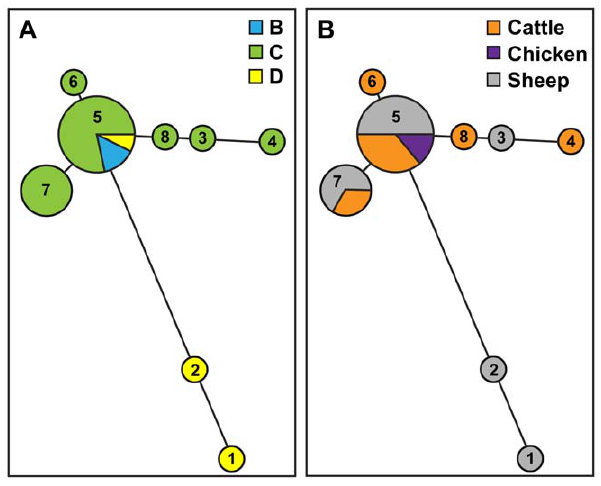
Figure 3. Phylogenetic relationships of MLVA types for the 26 O157:H7 STEC isolates. A minimum-spanning tree of MLVA types was generated with Bionumerics software v6.1 and the Manhattan distance algorithm. Each circle in the tree represents a different MLVA type, and the number in the circle indicates the MLVA type number. The circle size corresponds to the number of isolates with an identical MLVA type. Colors represent the sampling sites (A) or the sampling source (B) for each MLVA